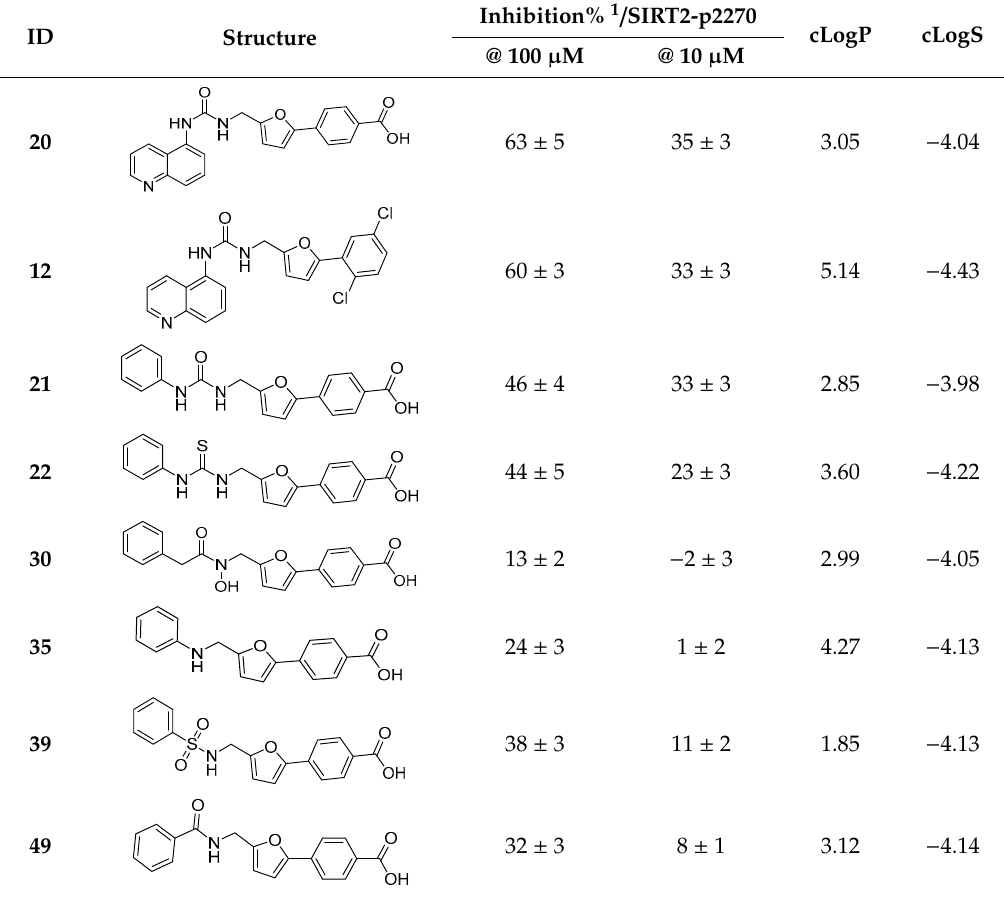
Table 1. The inhibitory activities and calculated clogP / clogS values of compounds 12 , 20 – 22 , 30 , 32